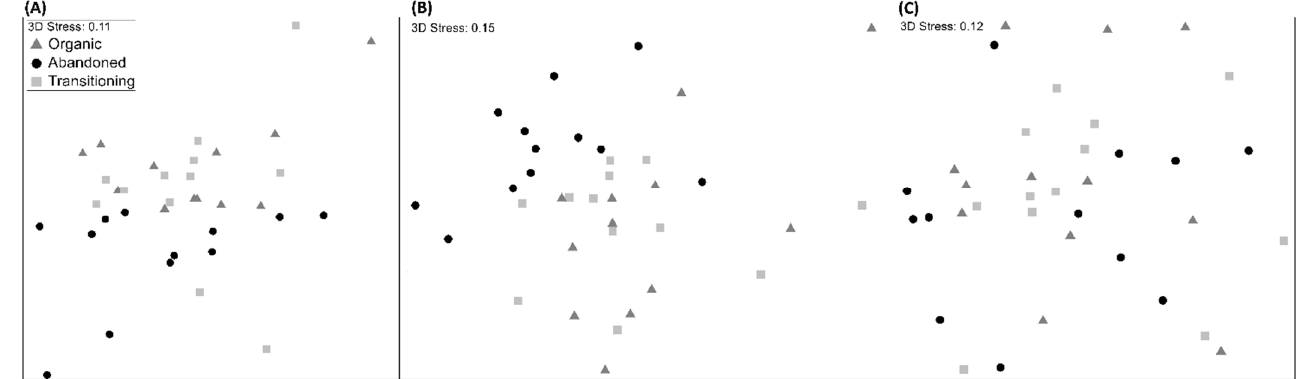
Figure 3. MDS of the natural enemy ( A ), spider ( B ), and parasitoid ( C ) communities sampled (Bray– Curtis index, square-root transformed abundances). Triangles: organic groves; circles: abandoned groves; squares: traditional groves.